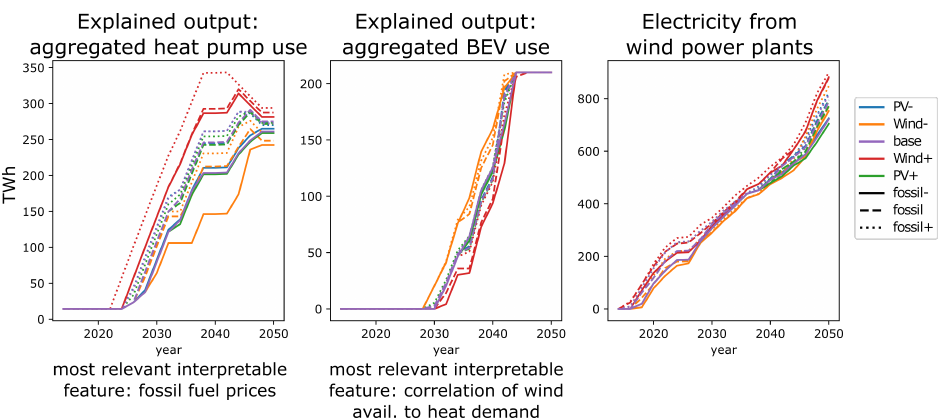
Figure 5. Yearly energy output of different technologies for different interpretable input variations in the German energy system model. Each line is a different variation with the color encoding the correlation of the PV or wind availability time series to the heat demand and the line style encoding the fossil fuel price. On the left is heat output by heat pumps. In the middle is propulsion output from battery electric vehicles. On the right is electricity output of wind onshore and offshore power plants. The most relevant interpretable feature for the transition speed towards heat pumps is fossil fuel prices. The importance of fossil fuel prices can be seen in the left graph of Figure 5. For variations with expensive fossil fuel prices, heat pumps are used earlier and to a greater extent than for cheap fossil fuel